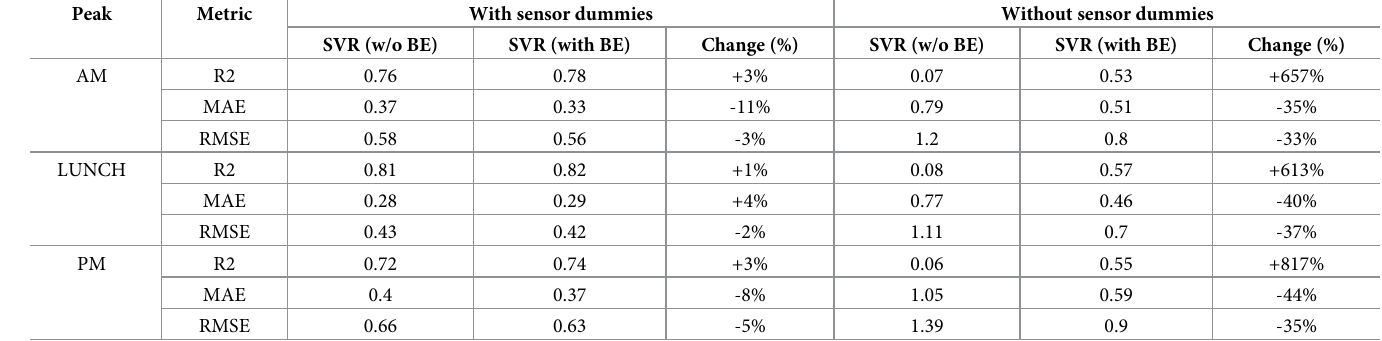
Table 4. Evaluating impact of built-environment measures on prediction with sensor dummies (left) and without (right). Prediction metrics for 2015 using a model calibrated on 2014 are presented. Peak